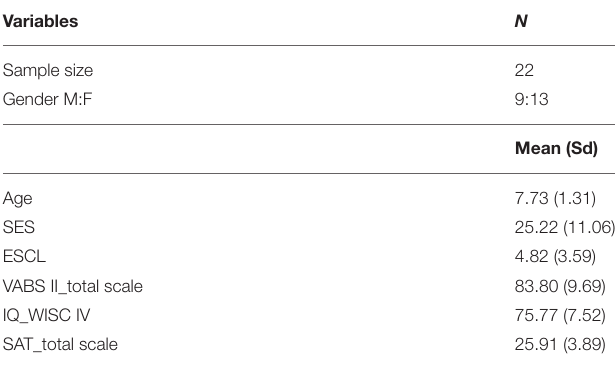
TABLE 1 | Demographic characteristics and neuropsychological